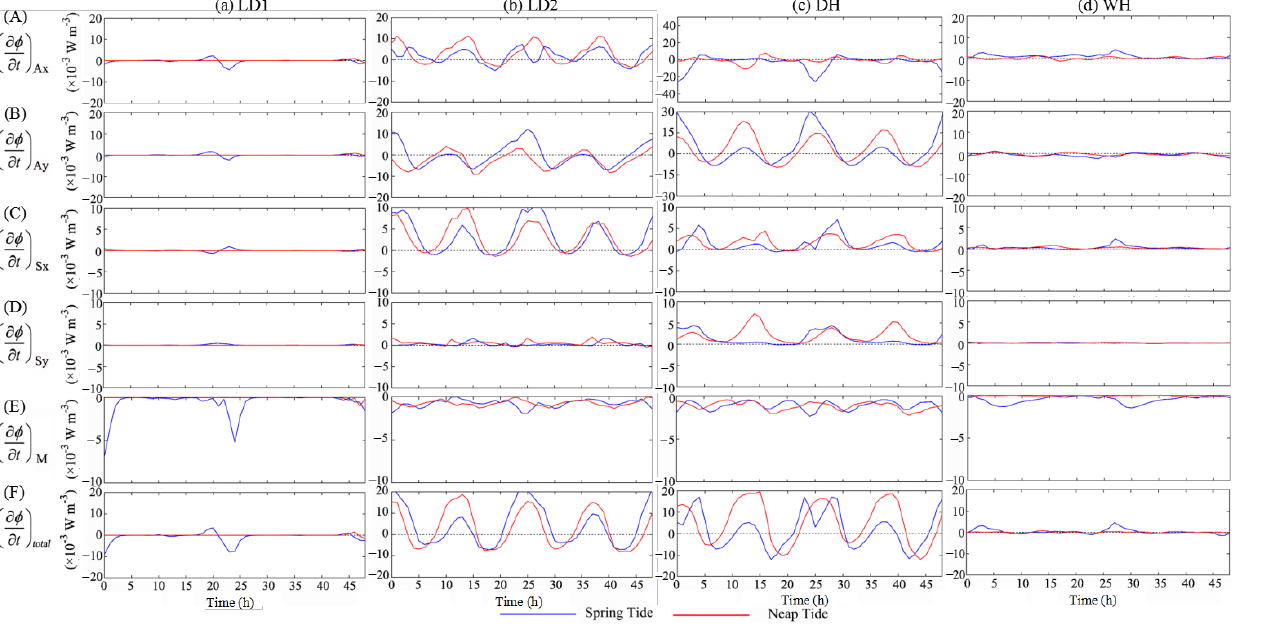
Figure 12 . Time series of (A) longitudinal advection; (B) lateral advection; (C) longitudinal depth- Figure 12. Time series of ( A ) longitudinal advection; ( B ) lateral advection; ( C ) longitudinal depth- mean straining; (D) lateral depth-mean straining; (E) vertical mixing; (F) the rate of change in total mean straining; ( D ) lateral depth-mean straining; ( E ) vertical mixing; ( F ) the rate of change in total potential energy at stations within the West Channel of the Pearl River Estuary. potential energy at stations within the West Channel of the Pearl River